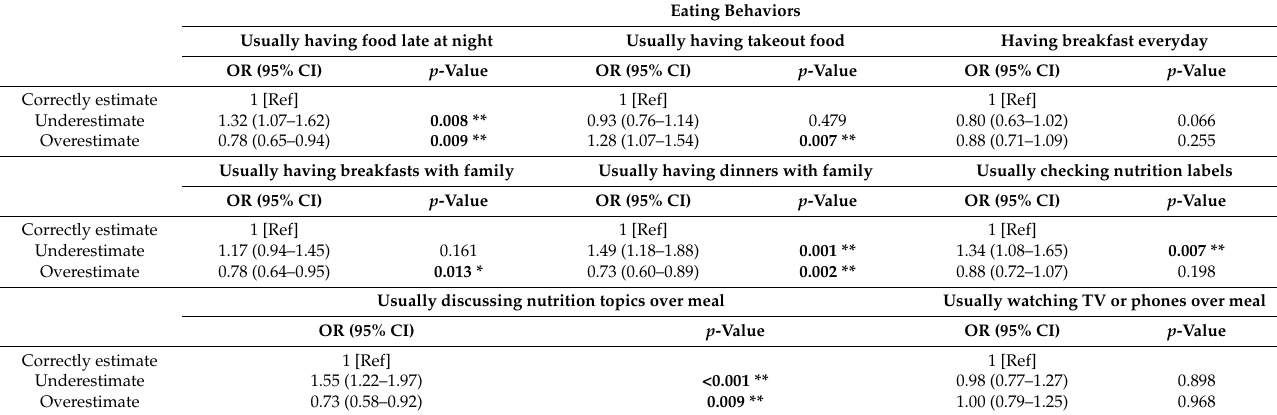
Table 5. Eating behaviors associated with weight misperception among participants (Logistic regressions, N = 2641). Eating Behaviors